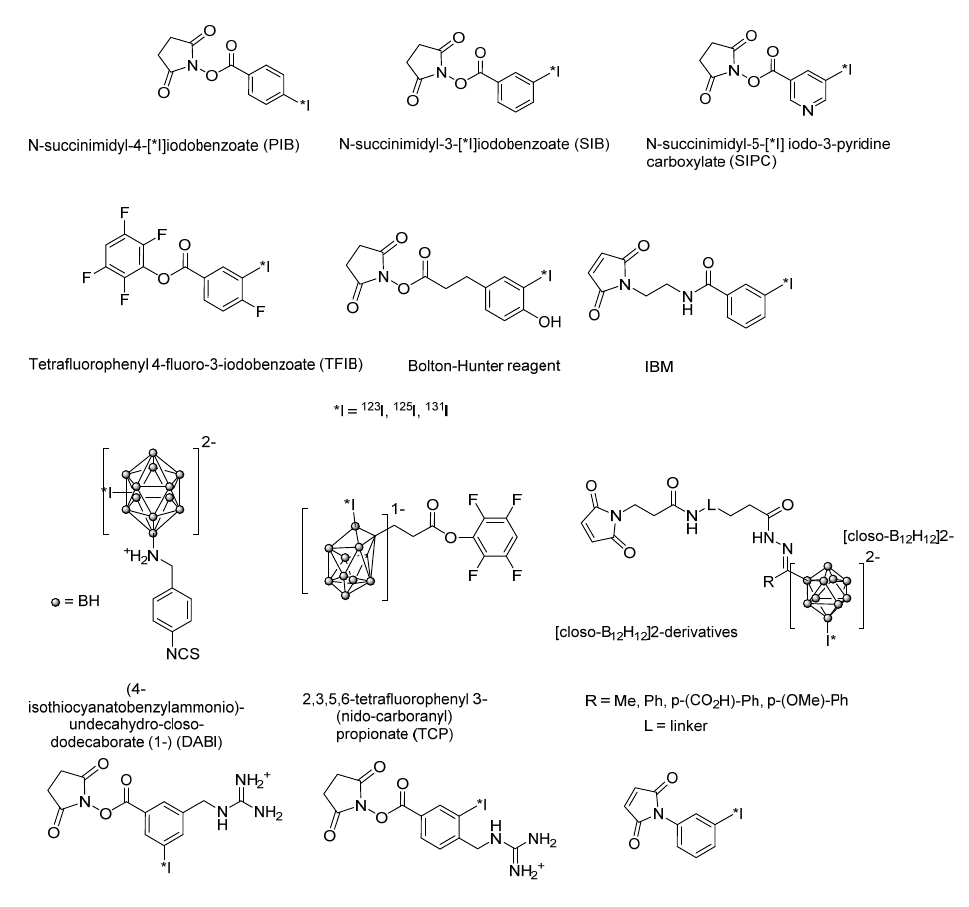
Figure 2. Typical prosthetic groups used in radioiodination of macromolecules.